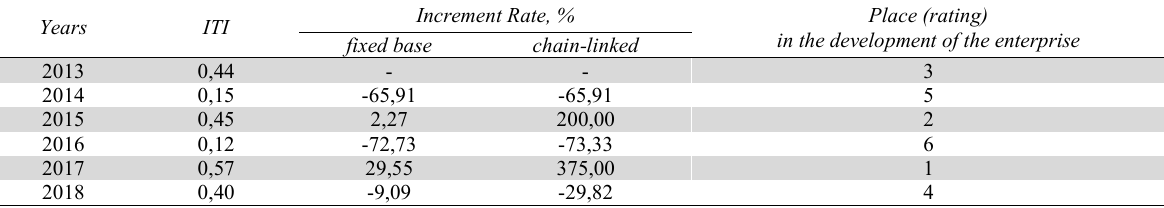
Increment Rate, % Place (rating)